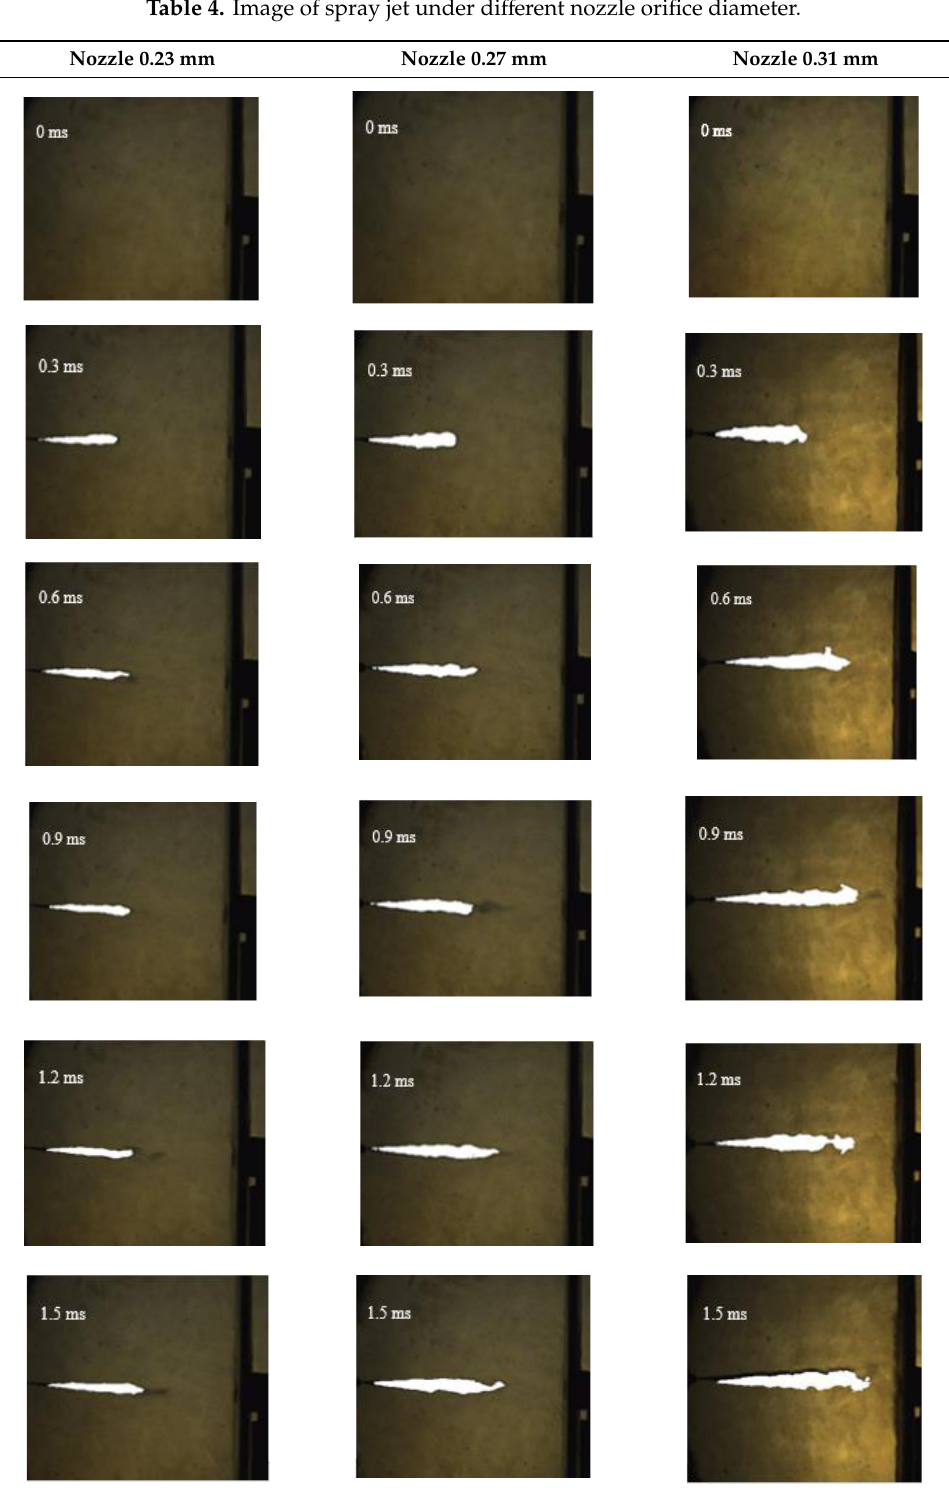
Table 4. Image of spray jet under different nozzle orifice diameter.